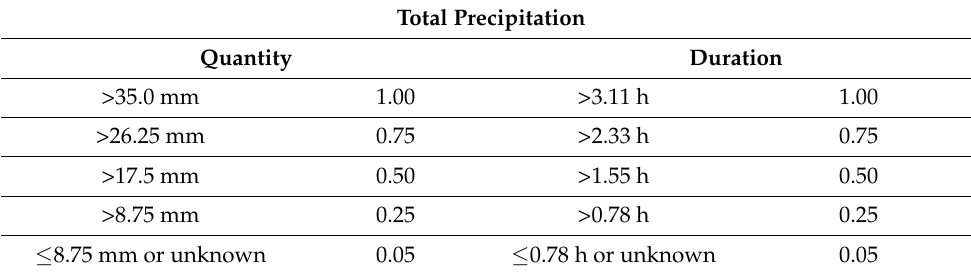
Table 7. Geological–hydrological category “Total Precipitation” and corresponding subcategories with probability